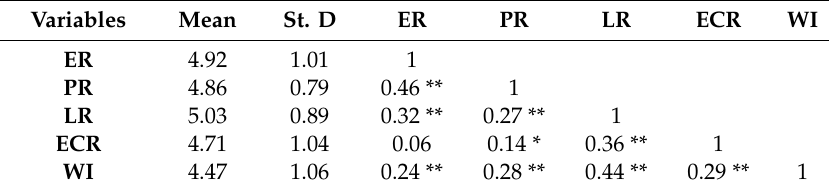
Table 5. Correlation analysis including Mean and Standard